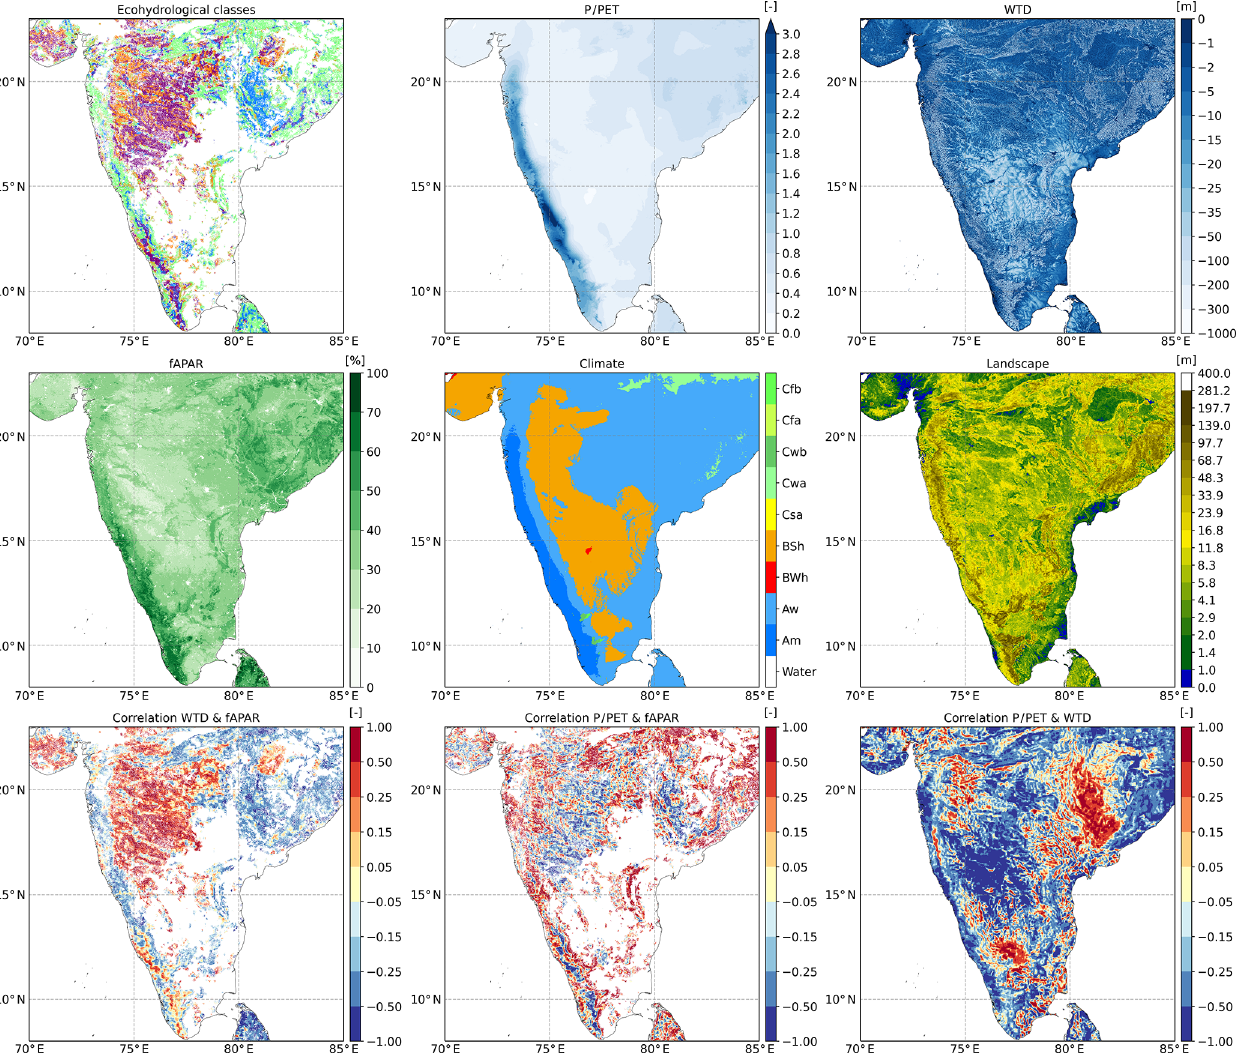
Figure 5. High-resolution illustration of ecohydrological classification over the Indian peninsula. Input and correlation maps are shown at the full resolution of 30arcsec. The white pixels in the upper left map (ecohydrological classes) represent the locations where the correlations were not calculated due to the tree height falling below the threshold value of